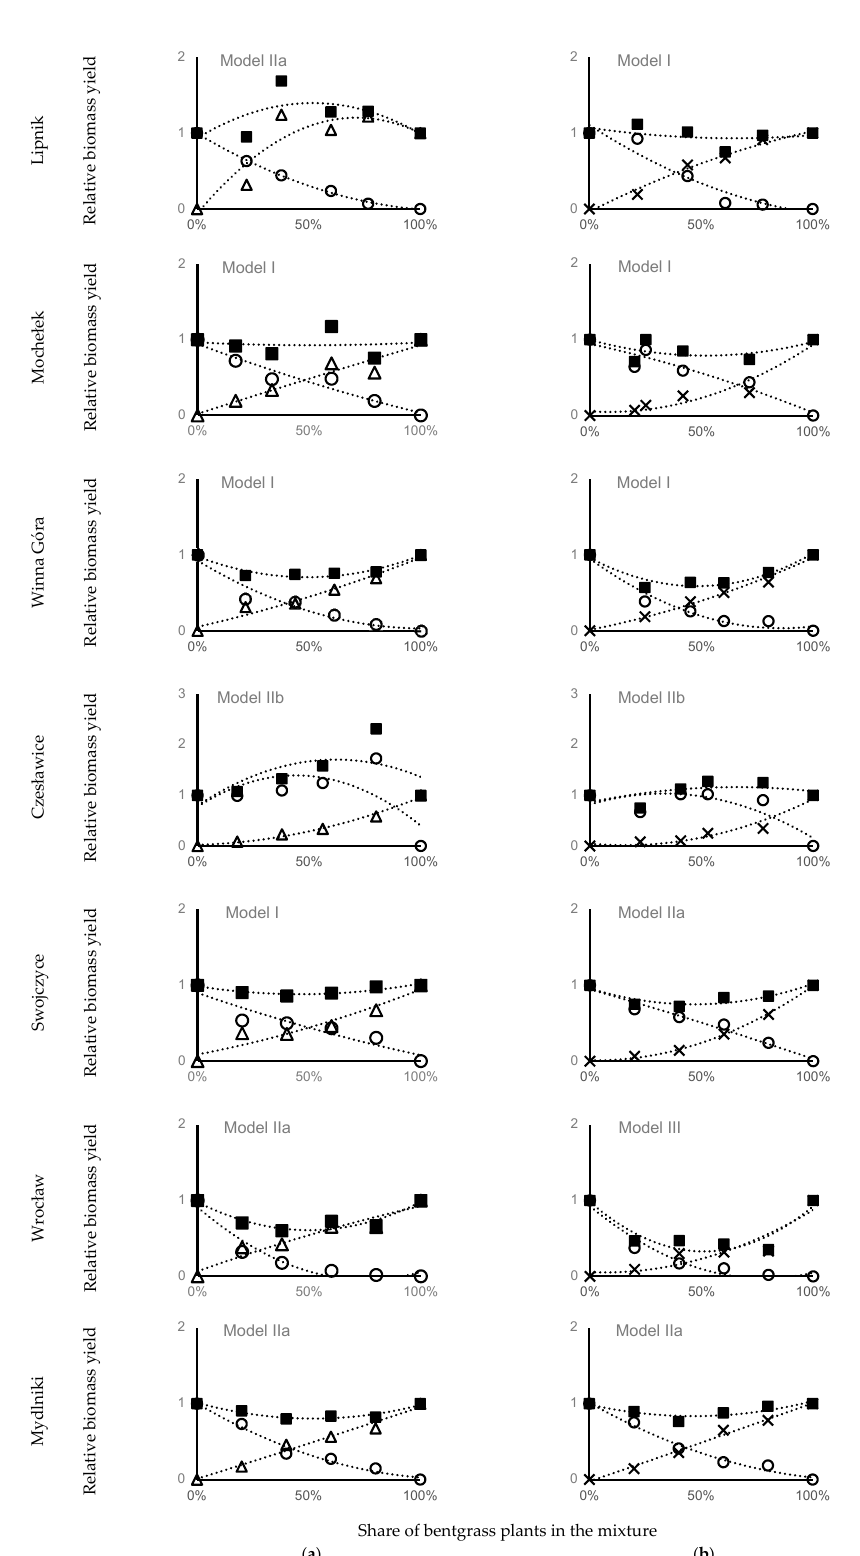
Figure 6. The substitutive competition model for the relative biomass yield of winter wheat (WW) and bentgrass in the 2018–2019 season, classified according to the t -test and p -values < 0.05. ( a ) Competition between WW and bentgrass with multiple herbicide resistance (RM), and (b) competition between WW and herbicide susceptible bentgrass (S). Legend: ○ —WW; Δ —RS; × —S; □ —RS + WW ( a ) or S + WW ( b ). A detailed analysis of the effect of competition between WW and BM or S on the grain number (Figure 7, Table S8) was different than that for plant biomass. In four out of seven sites, model I was confirmed for both BM and WW, and S and WW.